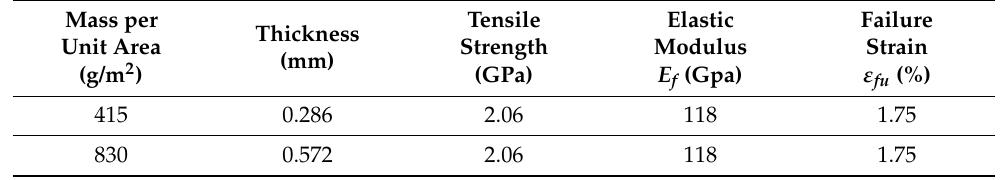
Table 2. Material properties of the AFRP sheets.